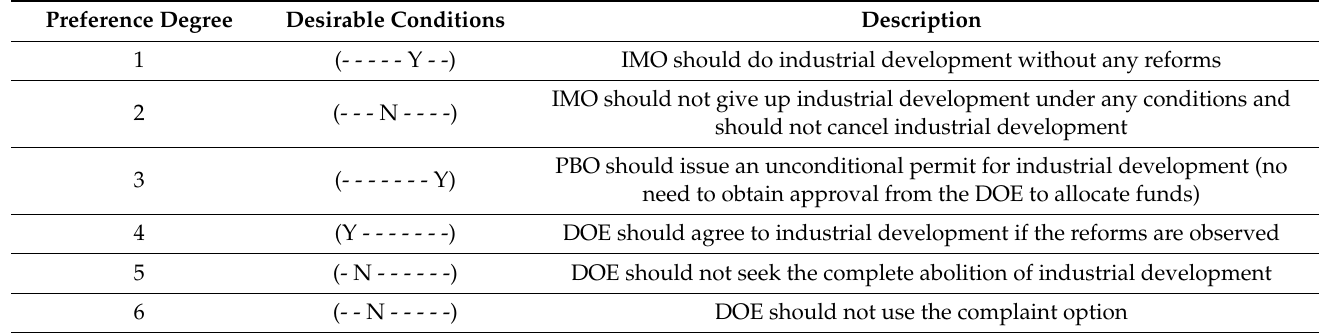
Table 6. IMO preferences (in order from most desirable to most undesirable conditions).